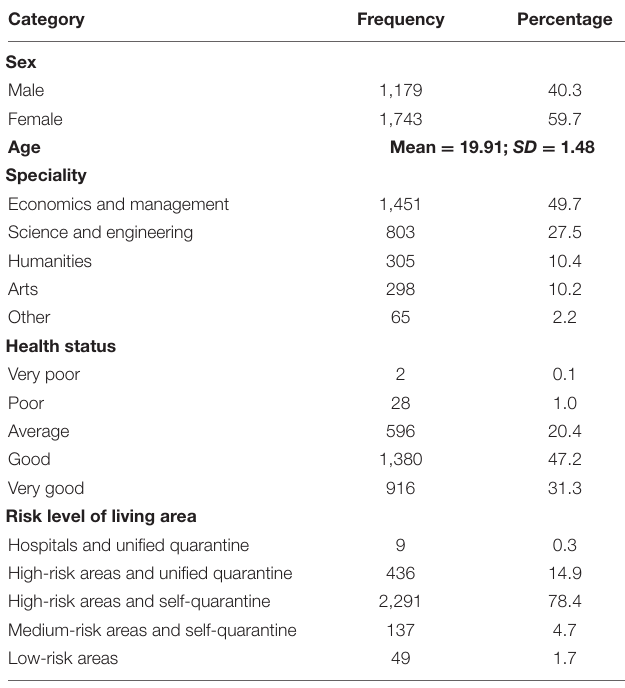
TABLE 1 | Baseline/socio-demographic characteristics of the sample ( N =